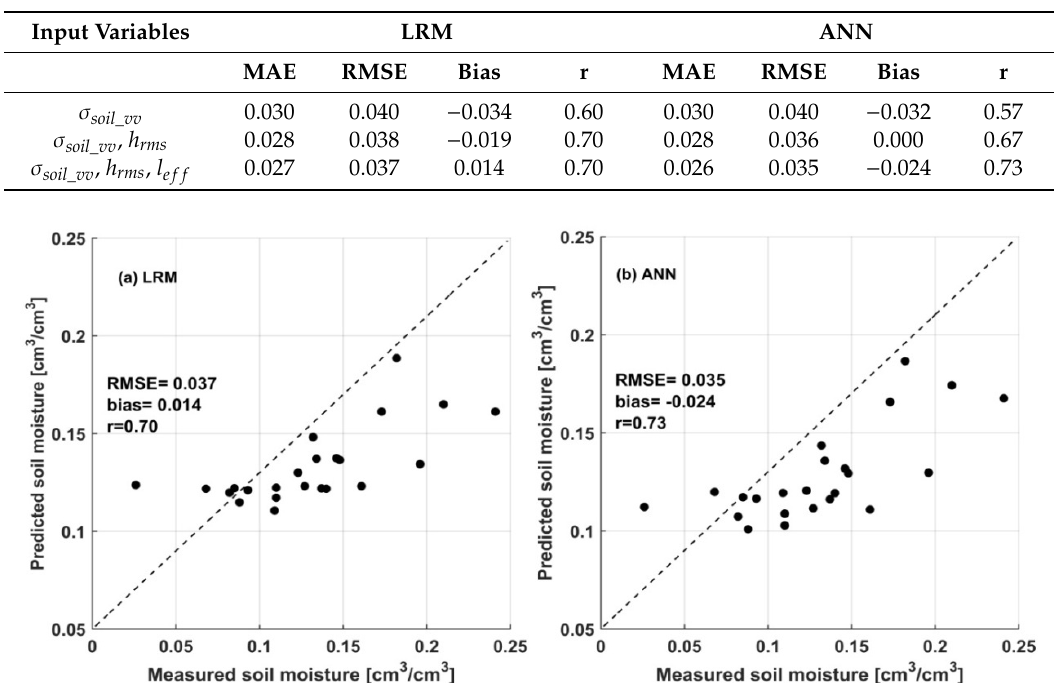
Table 4. Summary of the statistical performances of the soil moisture prediction model for the linear regression model (LRM) and the artificial neural network (ANN) methods using the three input configurations during the validation phase. The RMSE and MAE values are provided in terms of volumetric soil moisture (cm 3 / cm 3 ).